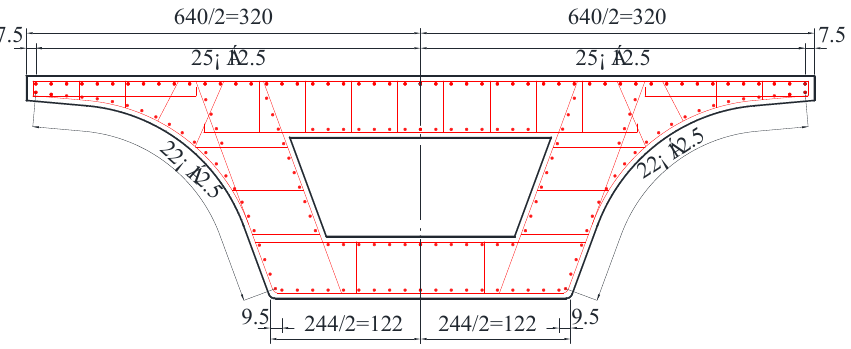
Figure 4. Section size of girder (Unit: